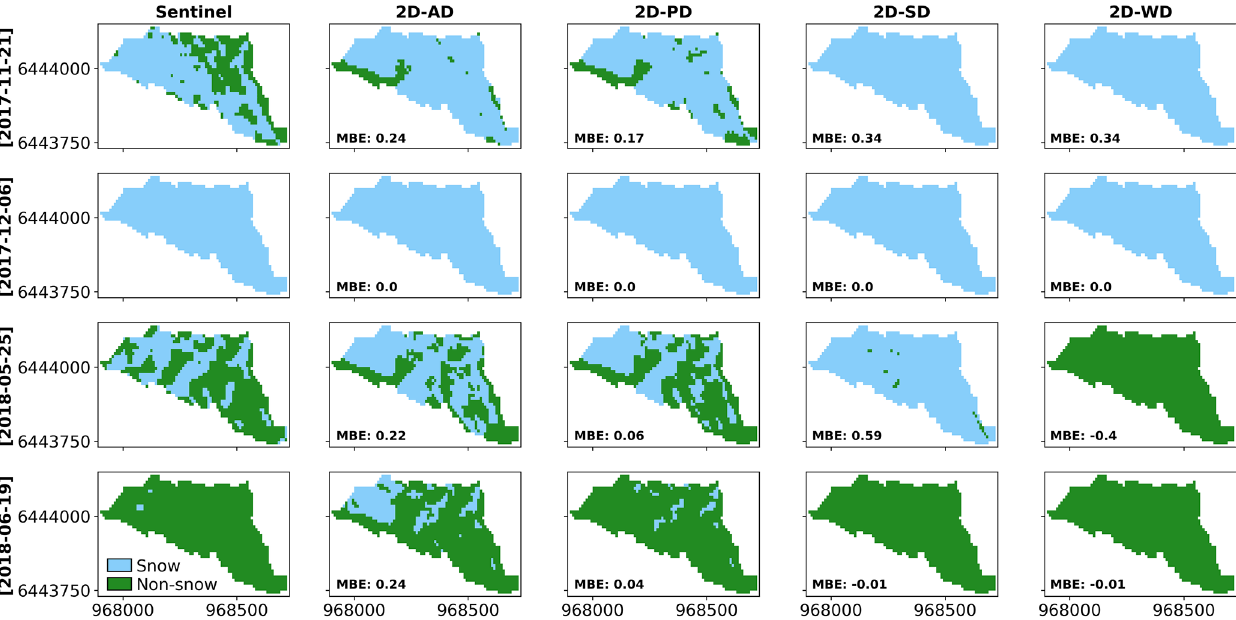
Figure 10. Snow maps for different simulations compared with the Sentinel-2 images for four cloud-free images: snow pixels (light sky blue) and non-snow pixels (green). MBE is the mean bias error between the model and Sentinel-2